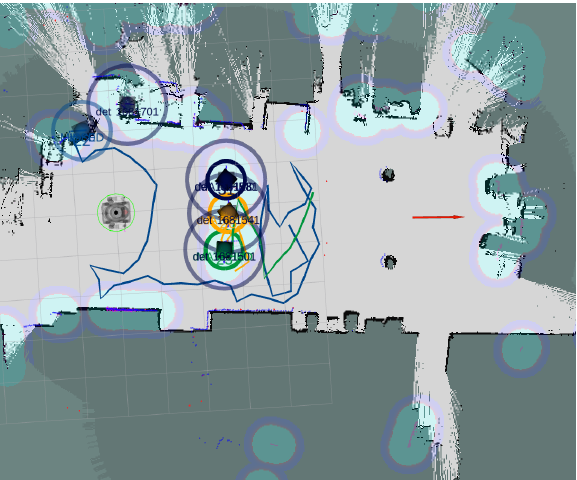
Figure 6. Real-life environments for experiments. In all the cases the robot goal is between the red columns.